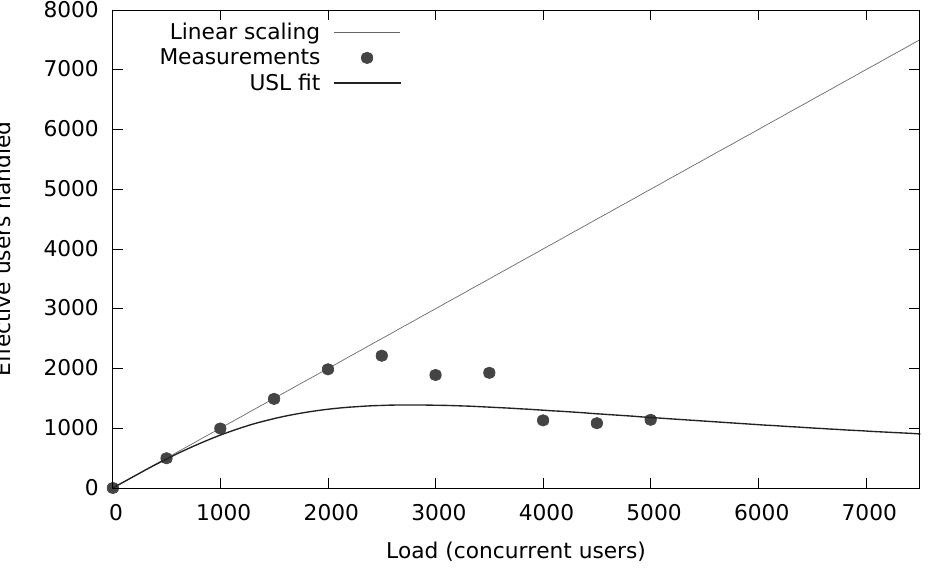
Figure 11. Fraud velocity rule with secondary